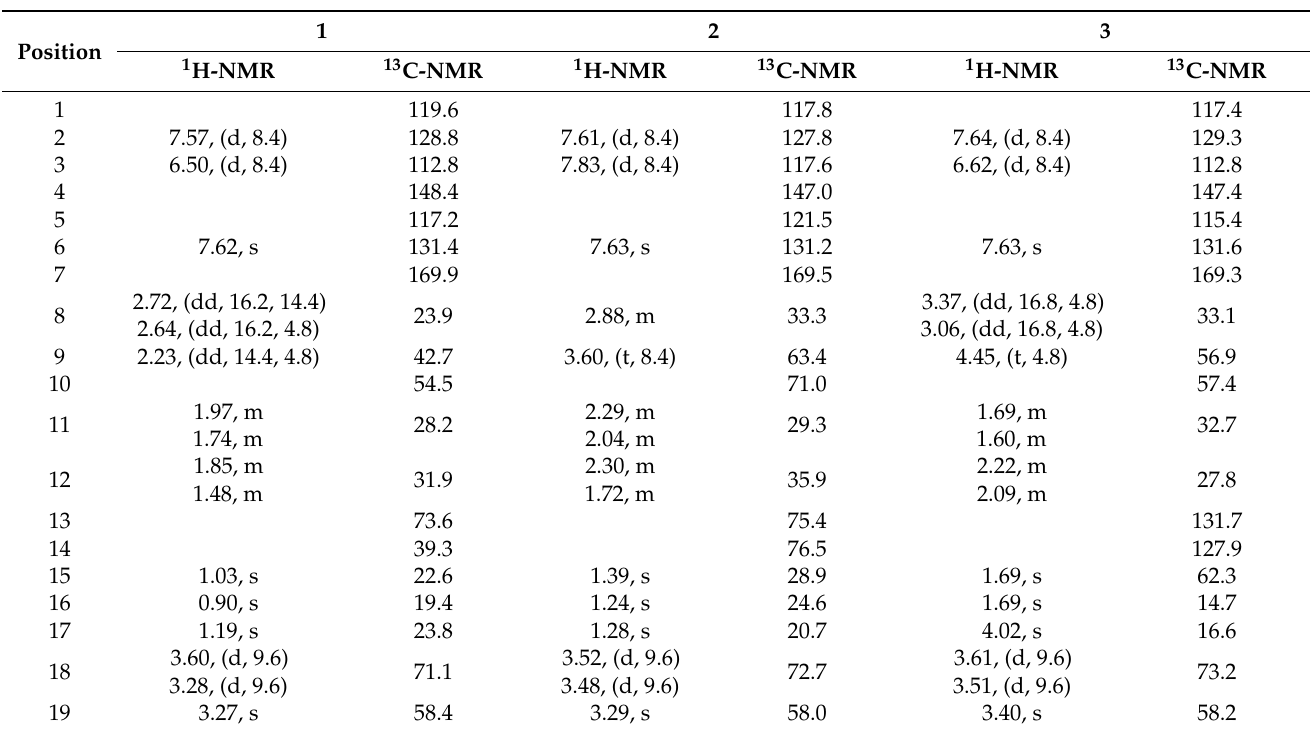
Table 1. The 1 H-NMR (600 MHz, J in Hz) and 13 C-NMR (150 MHz) spectroscopic data of compounds